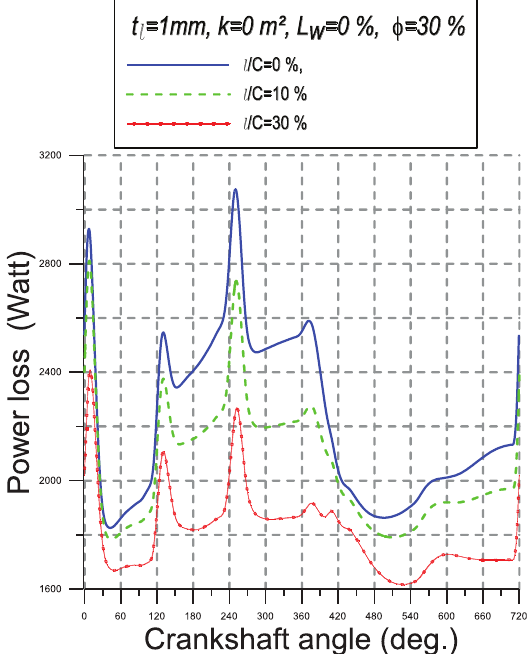
Fig. 18. Effects of the particle size parameter on power loss over an engine cycle.